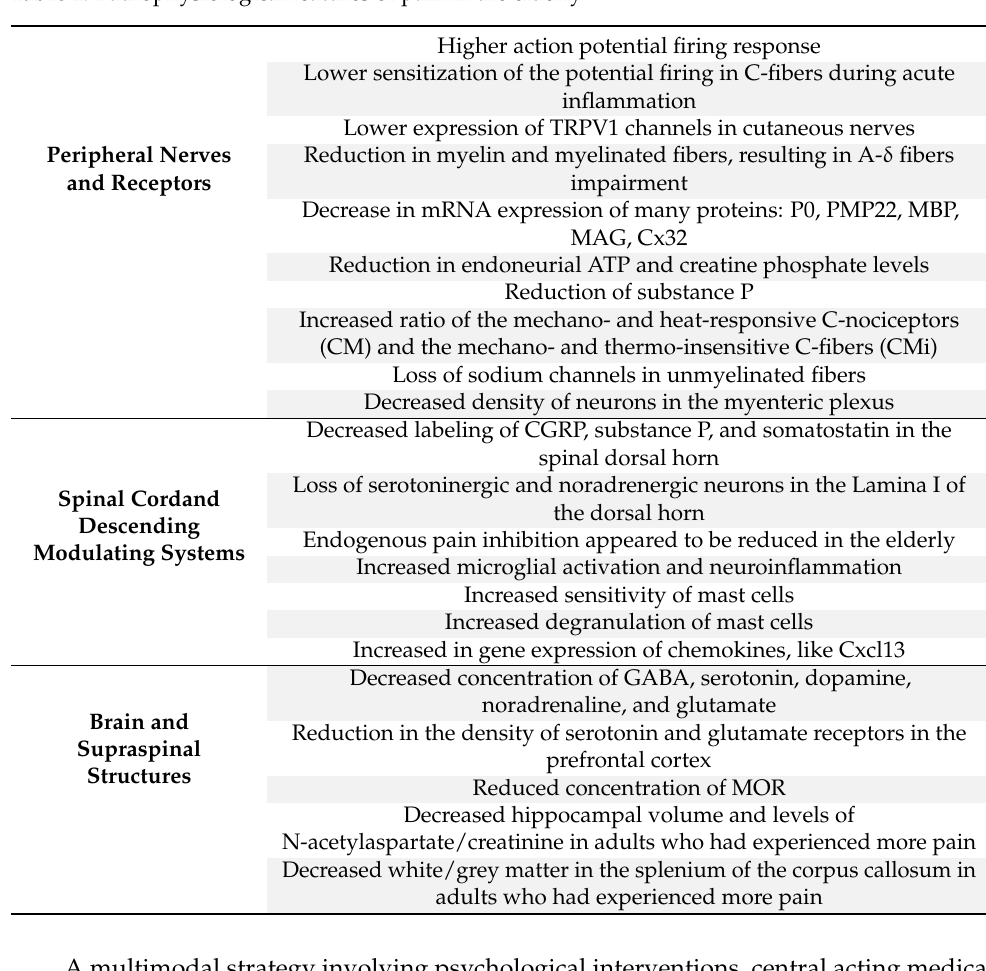
Table 1. Pathophysiological features of pain in the